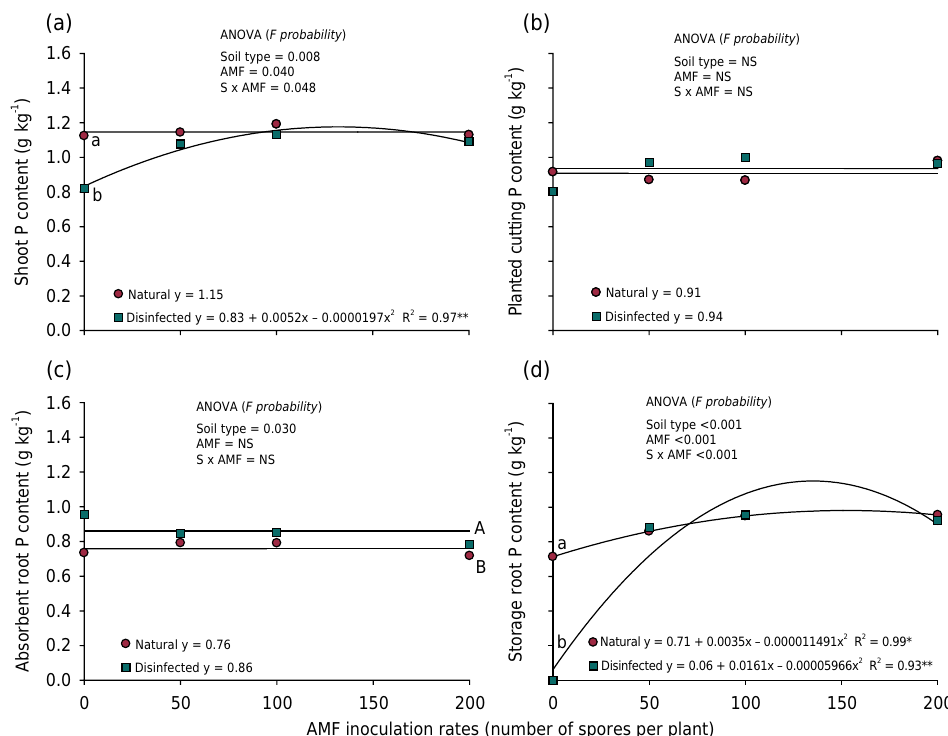
Figure 4. Phosphorus content in the shoot (a), planted cutting (b), absorbent roots (c) and storage roots (d) of the cassava in response to AMF inoculation rates in natural and disinfected soils. Within each AMF inoculation rate, different lowercase letters indicate a significant difference between soil types, whereas the absence of lowercase letters indicates a non-significant difference between soil types at p≤0.05. Different uppercase letters indicate a significant difference between soil types at p≤0.05 regardless of AMF inoculation rate. * p≤0.05; ** p≤0.01.